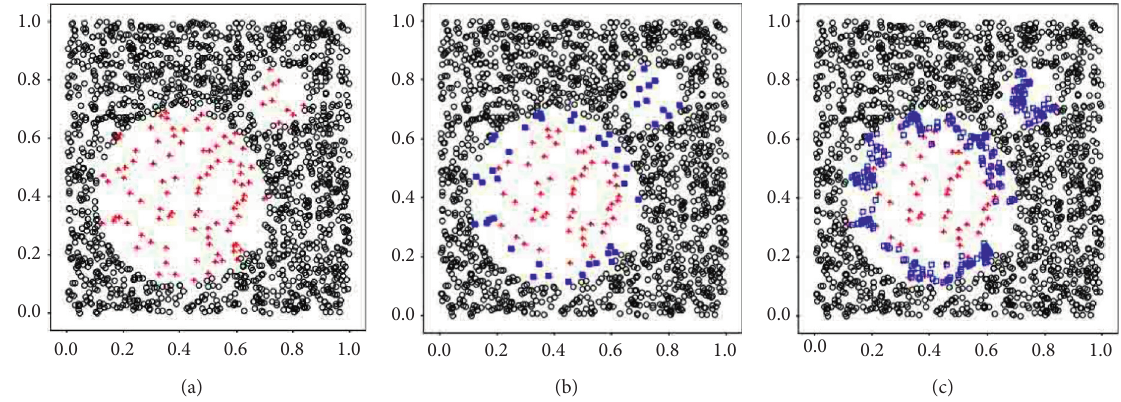
Figure 3: Schematic diagram of the synthetic instances by the borderline-SMOTE